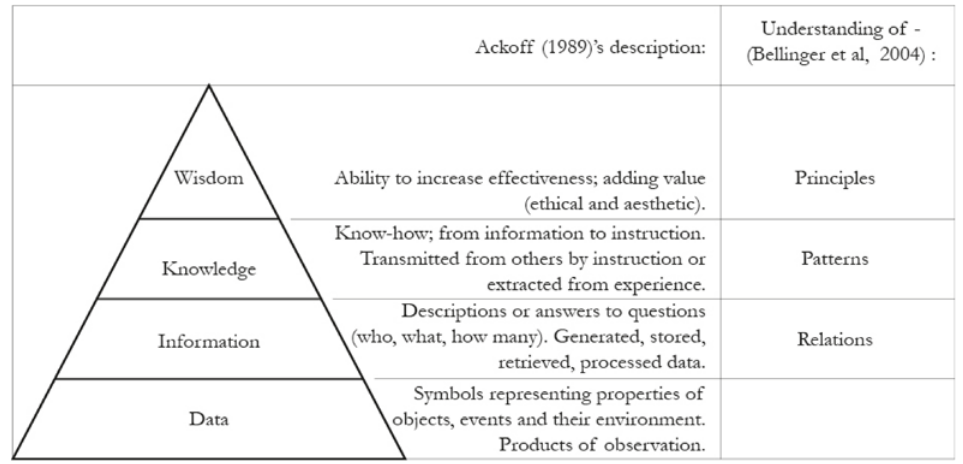
Figure 2 The data to wisdom hierarchy.